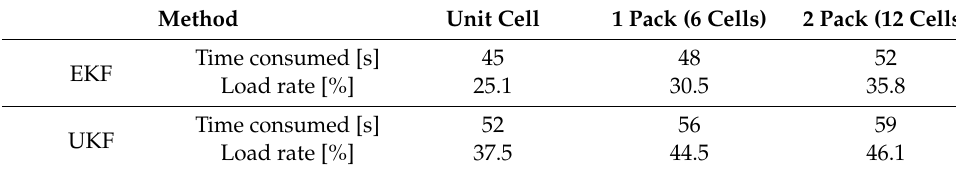
Table 4. Computing cost for initial deployment according to SOC estimation